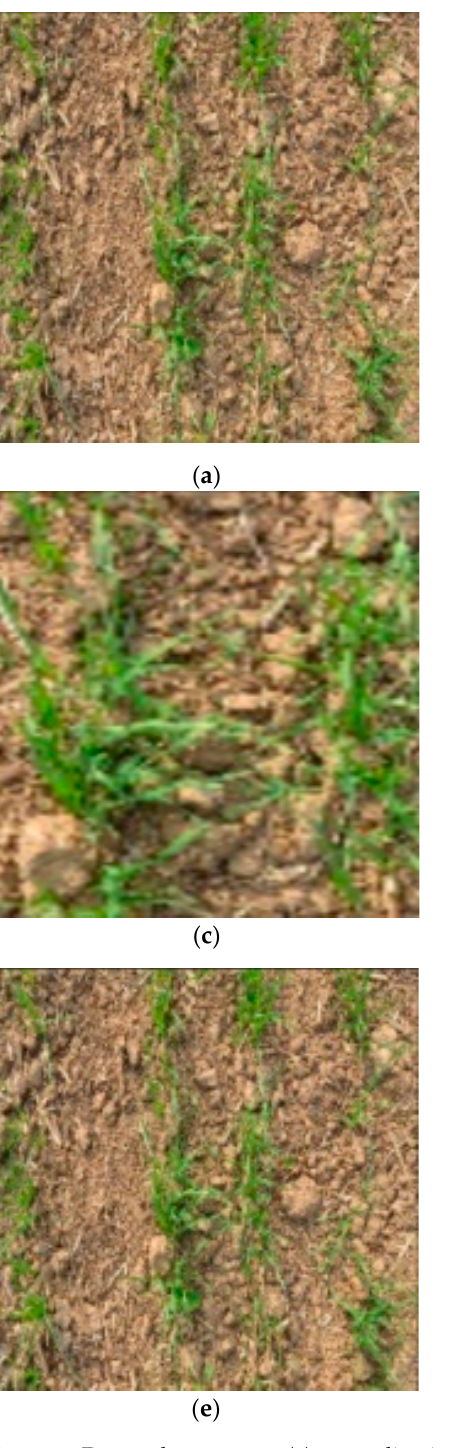
Figure 2. Data enhancement: ( a ) normalization; ( b ) dislocation transformation; ( c ) image scaling; ( d ) image flipping; ( e ) standardization. Table 1. Number of wheat canopy image samples.